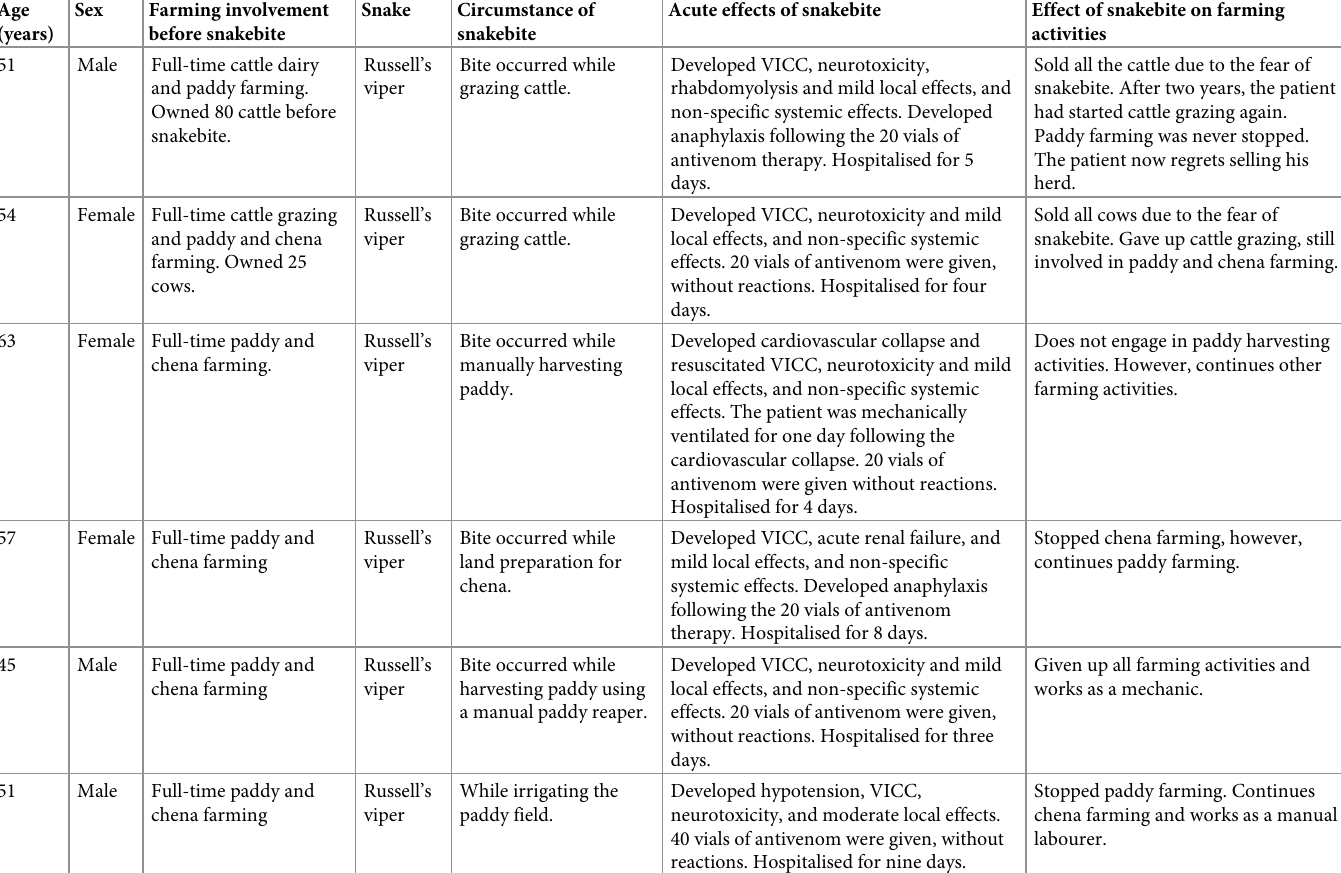
Acute effects of snakebite